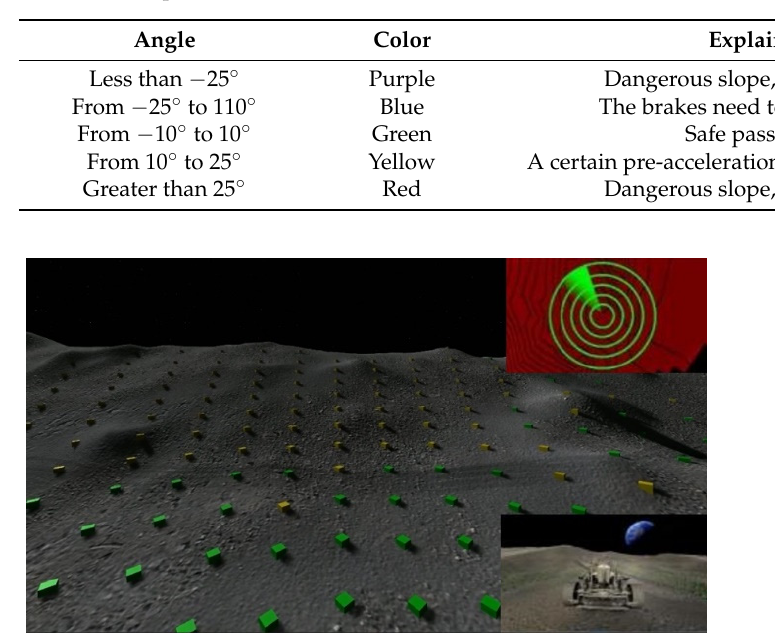
Figure 10. Virtual environment rendering.